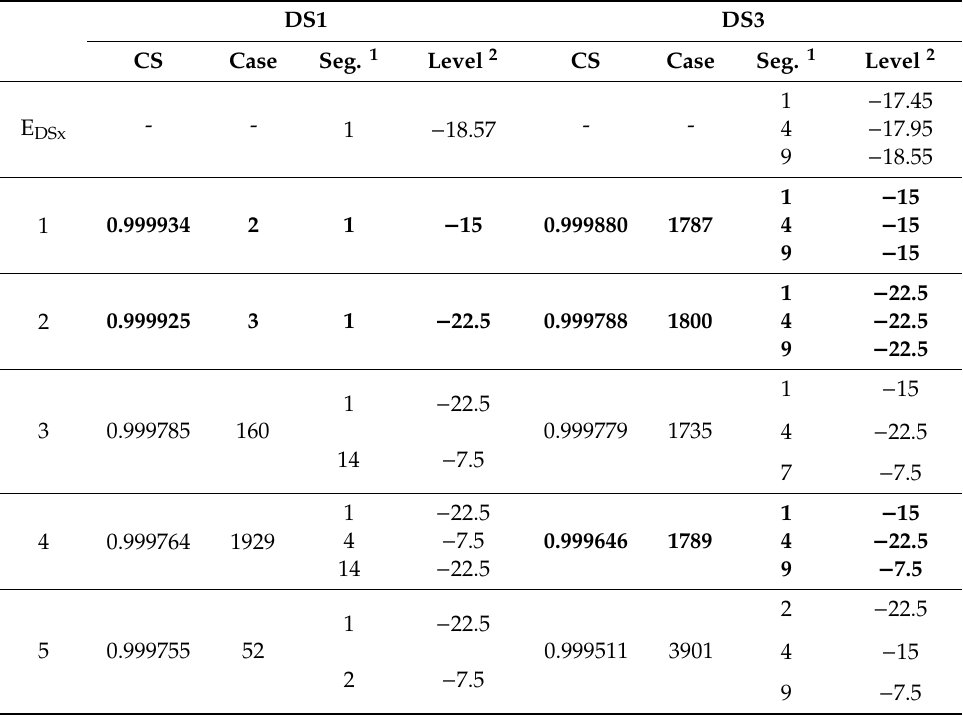
Table 8. The top five damage cases in cosine similarity with the first to fourth natural frequencies of the symmetric baseline model.